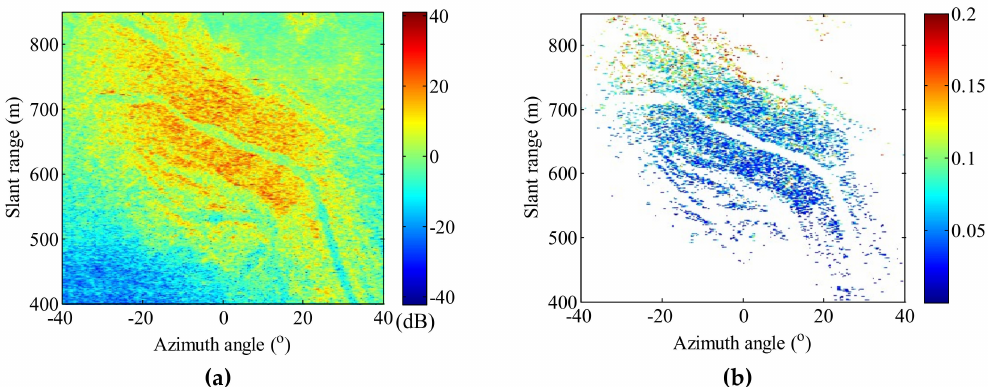
Figure 3. ( a ) Power image of the monitoring area. ( b ) Permanent scatterer (PS) selection result of